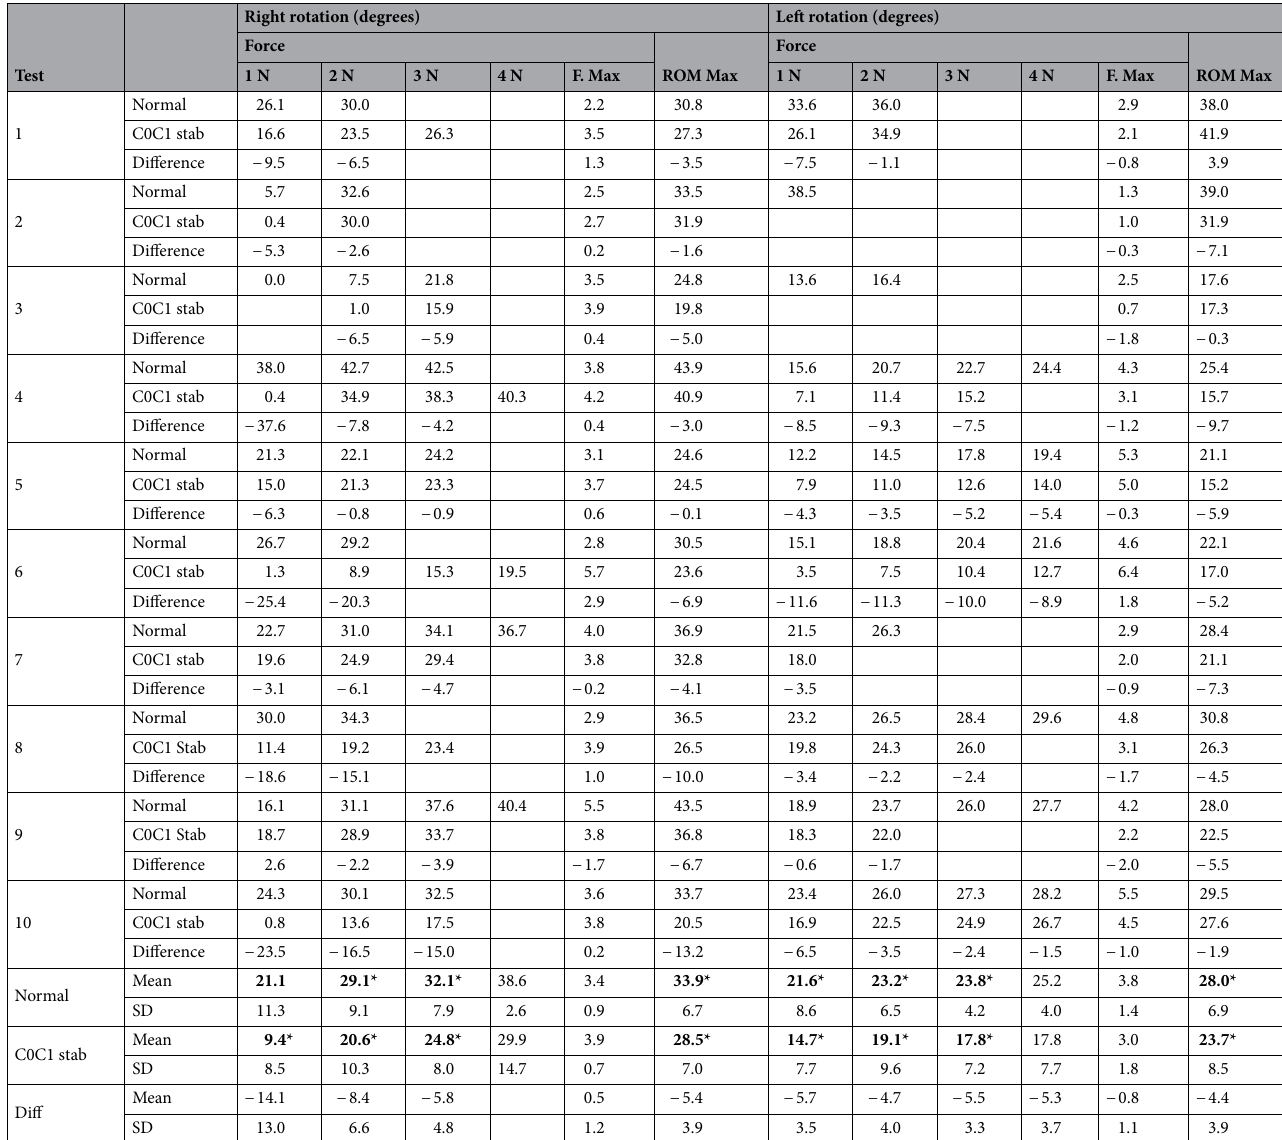
Table 4. Rotation in degrees for the force values of 1, 2, 3, and 4 N during the motion, and the maximum force (F. Max) with its range of motion (ROM Max). The table shows the values for all the specimens before (normal) and after (C0C1 stab) the stabilization of C0–C1. The means and standard deviations for each analyzed force and ROM Max are presented at the last rows of the table. N: Newtons; F max: applied force at end range of motion; ROM max: end range of motion; SD: standard deviation. *Statistical significance p < 0.05 values indicated in